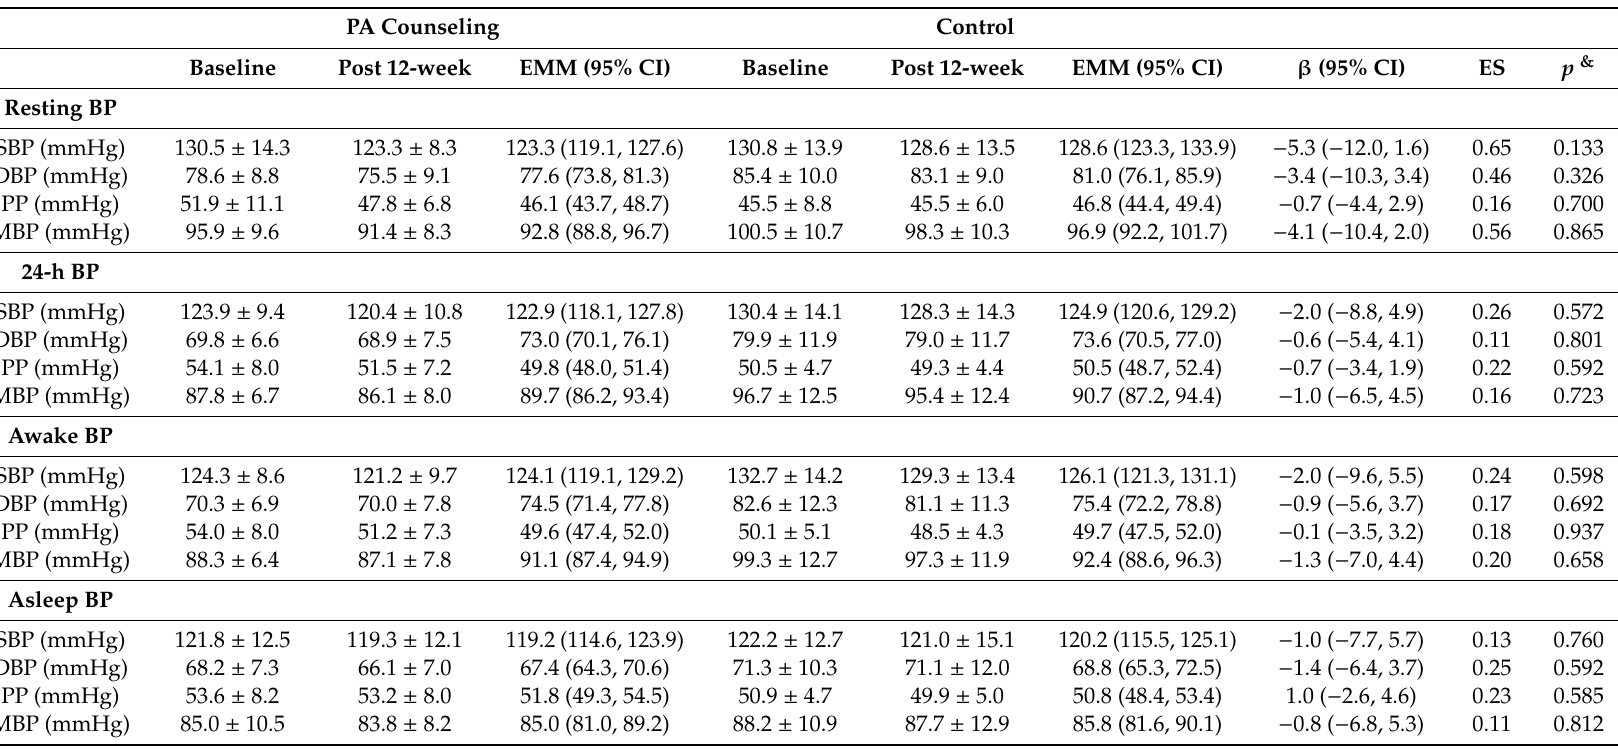
Table 2. Resting and ambulatory blood pressure of the participants from the physical activity (PA) counseling program group and control group at baseline and after 12